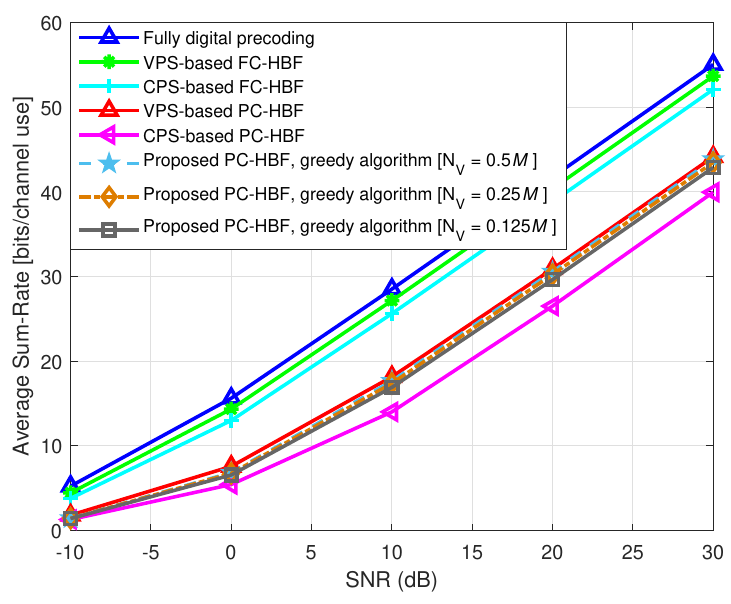
Figure 3. Average sum rate versus SNR. N t = 64 and U =